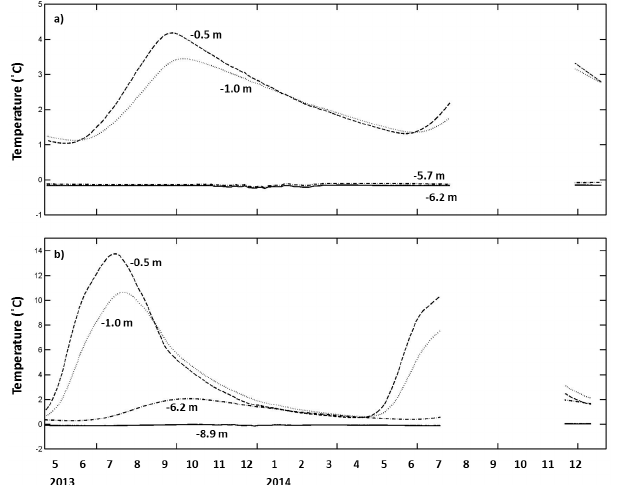
Figure 5. Depth profiles for sediment geochemical characteristics: total carbon (C tot ), organic carbon (C org ), total N (N tot ), C tot : N tot ratios, δ 13 C org , and δ 15 N tot . Values for the Vault Lake core are in the top panel; values for the Vault Creek permafrost tunnel are in the bottom